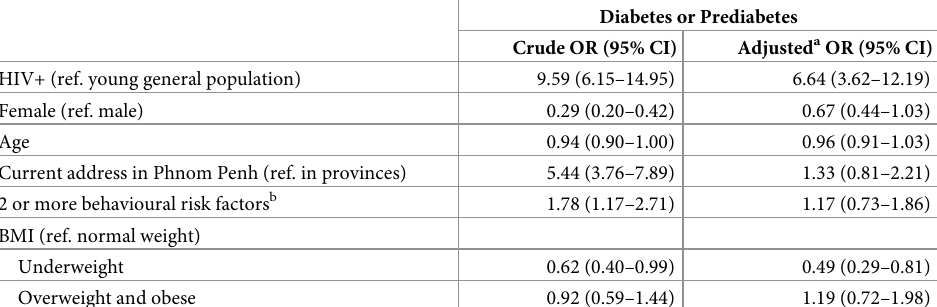
Table 2. Association between diabetes/prediabetes and HIV, STEPS, Cambodia, 2016 and 2019/2020.